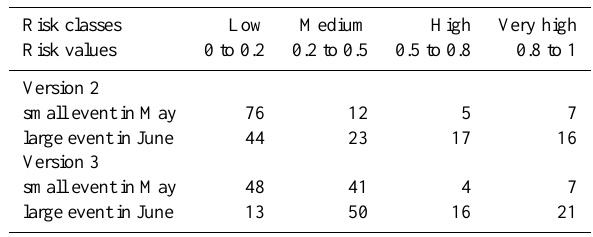
Table 5. Spatial extent of risk classes in the Stägbach catchment for different model versions and two runoff events in 2010 – relative to the total agricultural area in %.